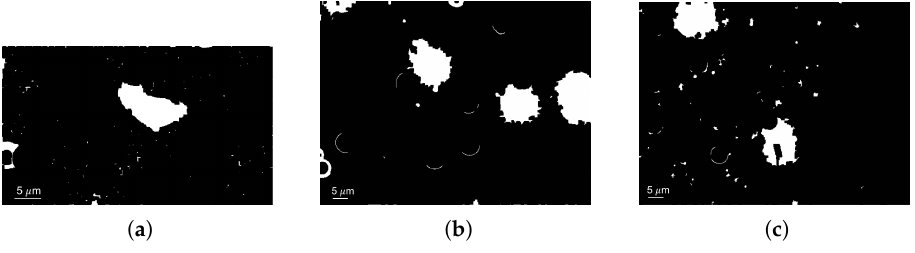
( x , y ) ; ( b ) I sw ( x , y ) ; ( c ) I sm ( x , y ) jer jer jer